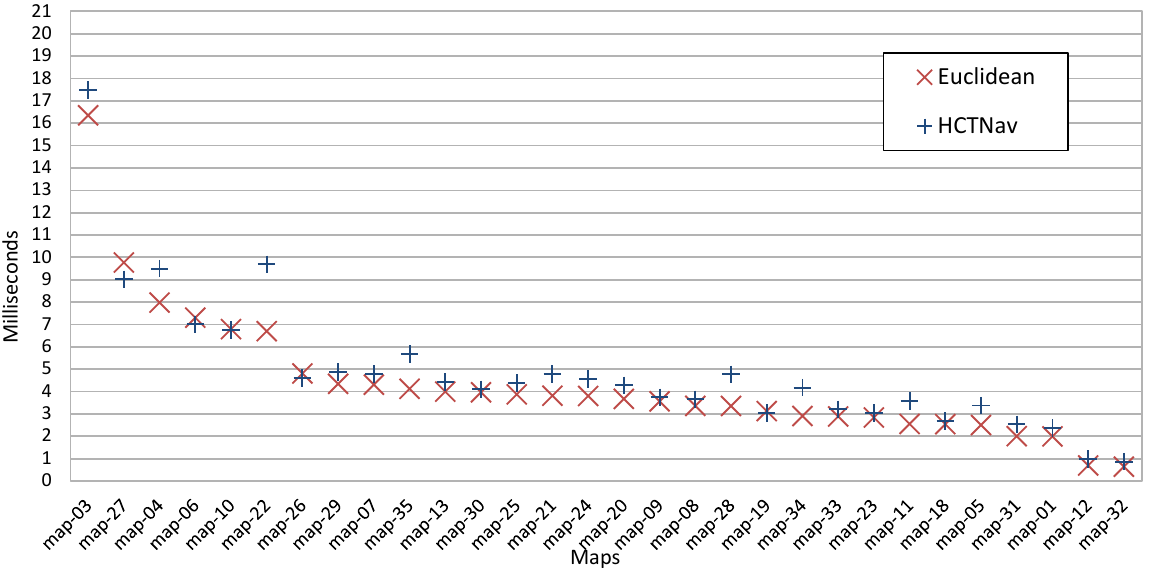
Figure 9. Execution time comparison (average single-path search). Maps have